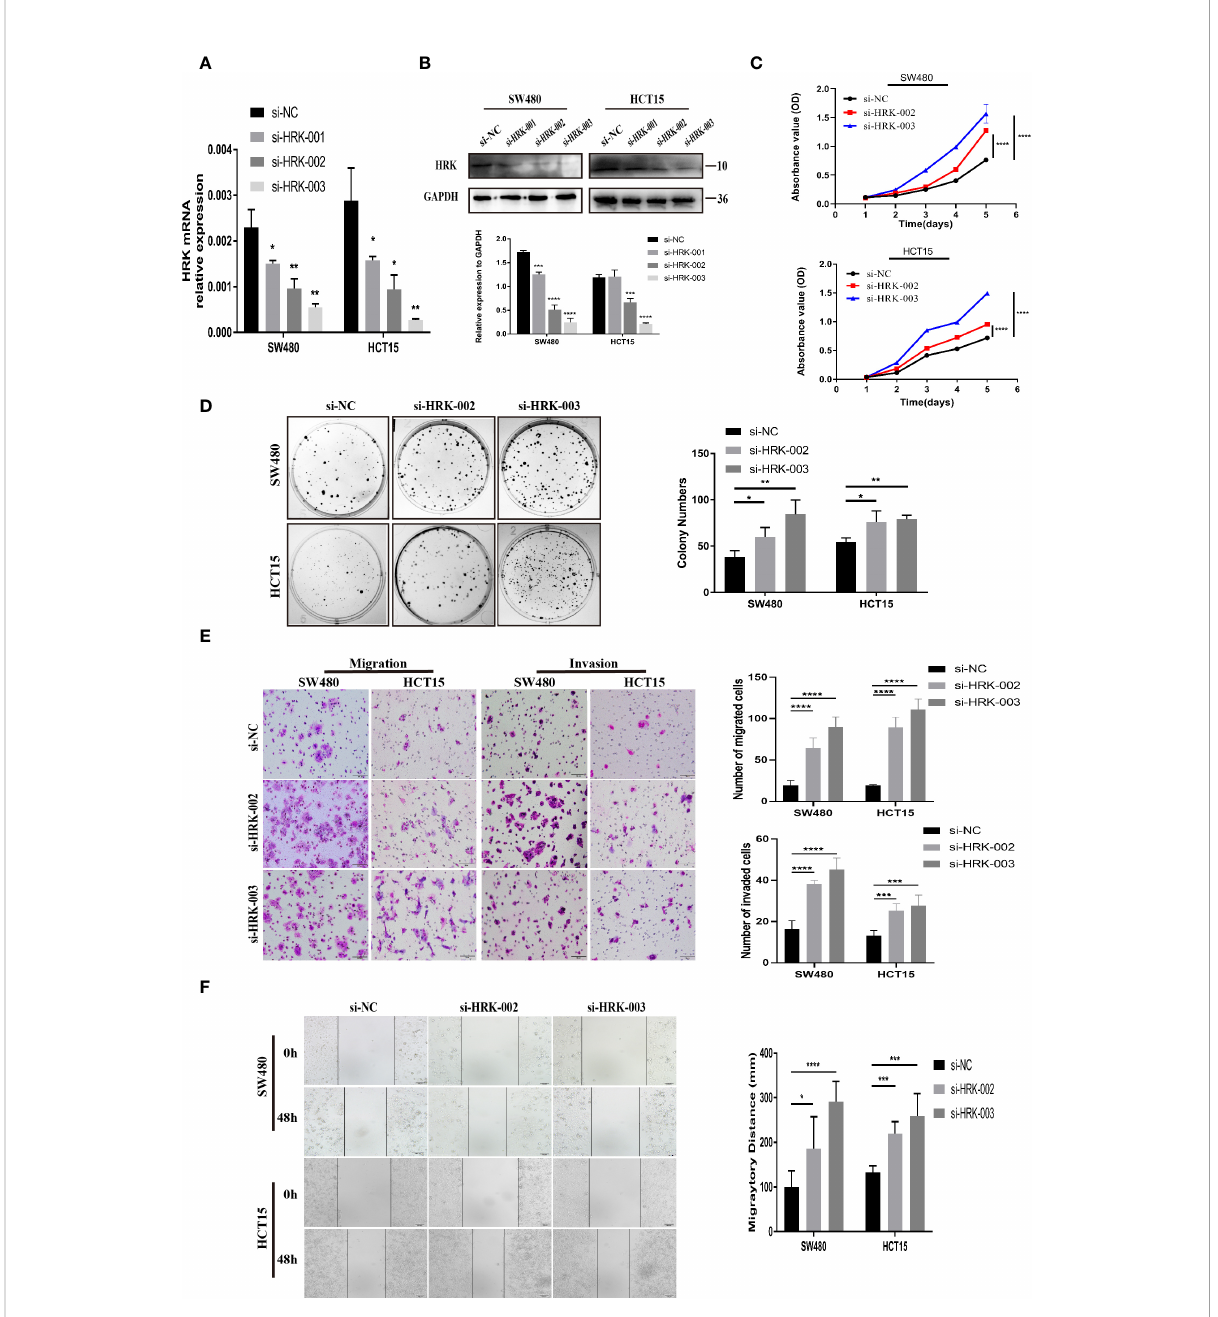
FIGURE 3 HRK reduction mediated by siRNA promotes CRC cell proliferation, migration, and invasion in vitro . (A, B) , knockdown expression of HRK after transfection with siRNA was con fi rmed in 2 CRC cell lines by Real time RT-PCR and western blotting. (C) , HRK reduction promoted cell proliferation of HCT15 and SW480 cells. (D) , Depletion of HRK increased the ability of HCT15 and SW480 cells to form colonies. (E) , Matrigel transwell assays were used to determine the invasion ability of HRK-downregulated CRC cells. Matrigel-free transwell assays showing the migration ability of HRK-downregulated CRC cells. (F) , Wound healing assays assessed the migration capability of HRK-downregulated CRC cells. Data are presented as the mean ± SD. The results were reproducible in 3 independent experiments. * P < 0.05, ** P < 0.01, *** P < 0.001 and **** P <